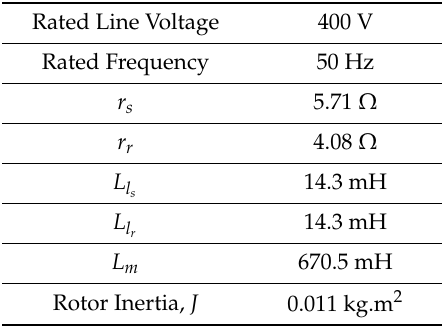
Table A1. Complete parameters of the adopted IM